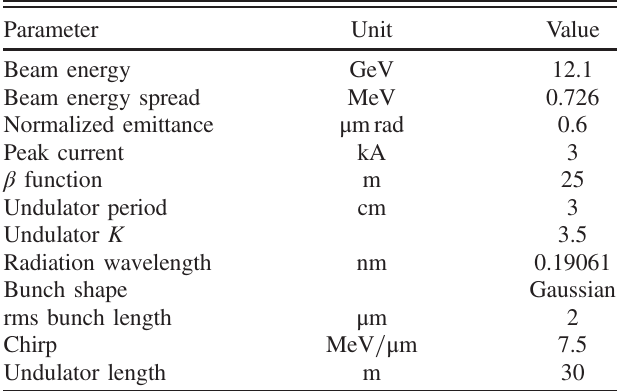
TABLE II. 1D FEL simulation parameters.